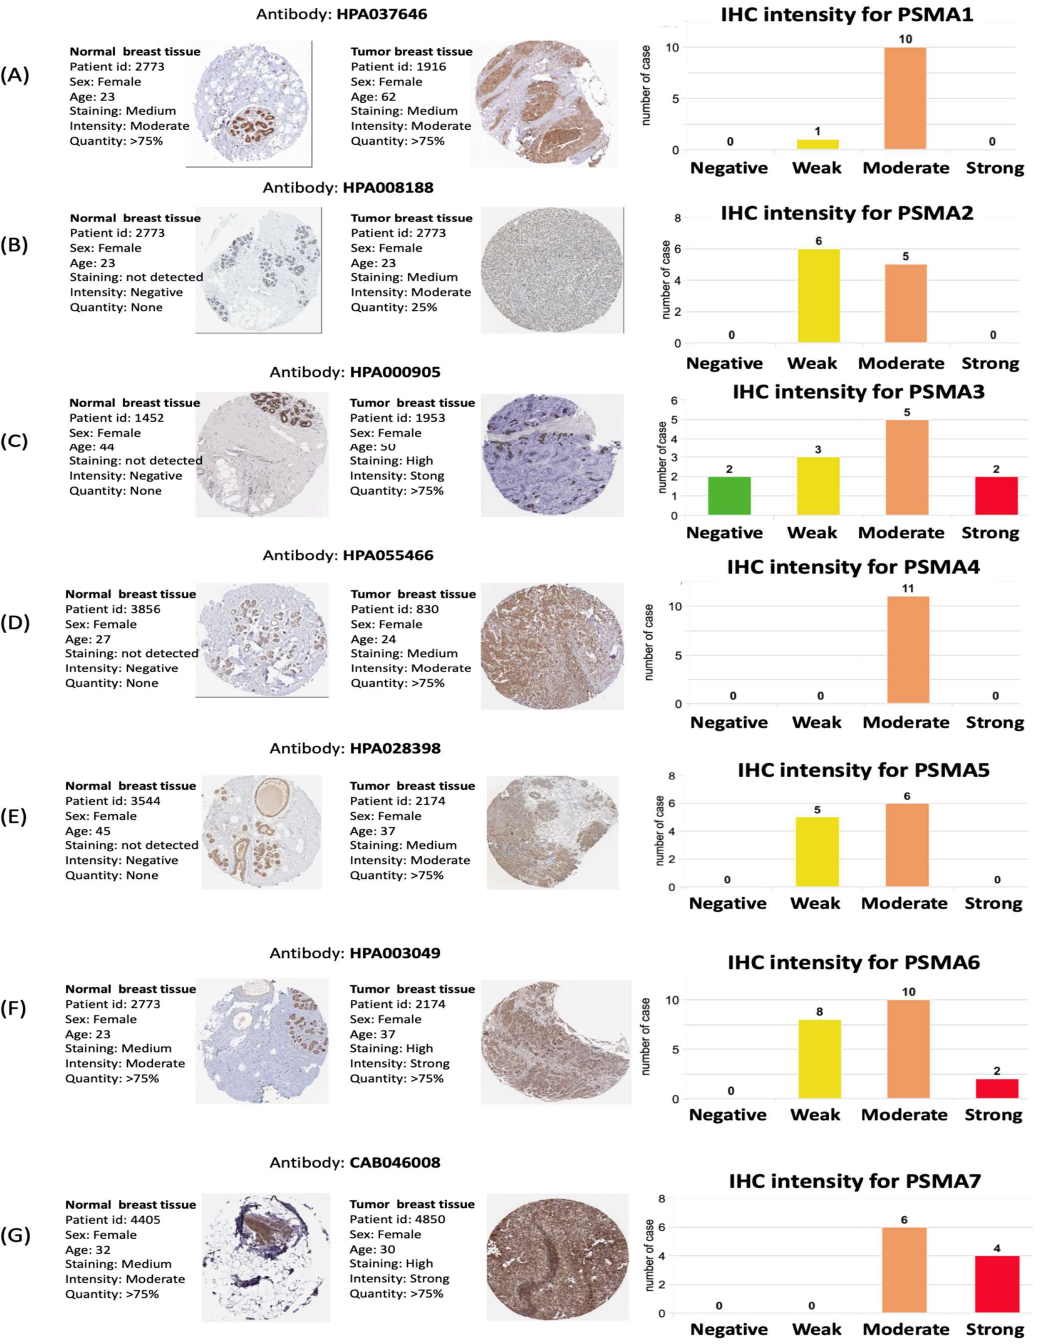
Figure 3. Protein expression levels of proteasome 20S subunit alpha (PSMA) family members across clinical breast cancer specimens from the Human Protein Atlas. ( A – G ) PSMA3, PSMA6, and PSMA7 showed high protein expression levels, and most PSMA family members showed medium protein expression levels in breast cancer specimens. All IHC images and patient information were acquired from the Human Protein